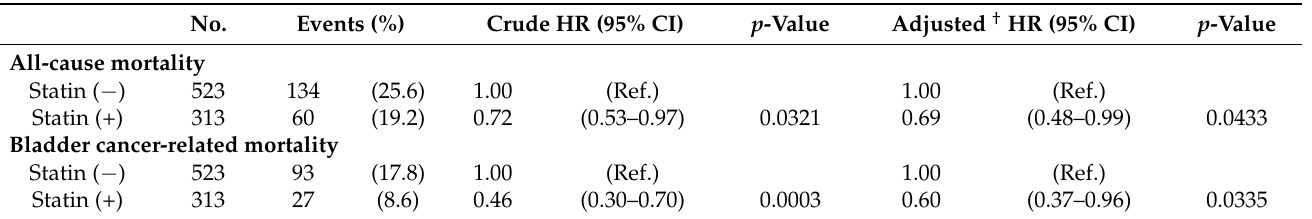
Table 2. Cox proportional-hazards model of mortality among stage 0–I bladder cancer patients with and without statins